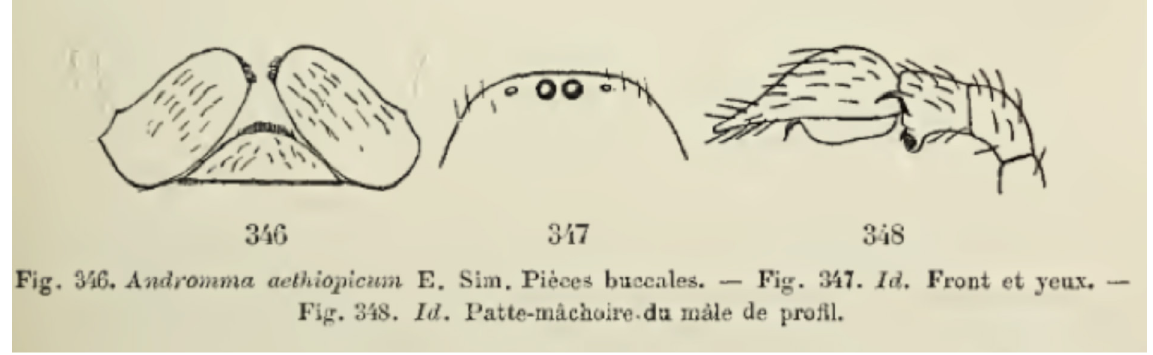
Fig. 3. Andromma aethiopicum Simon, 1893. Original drawings and legend from Simon